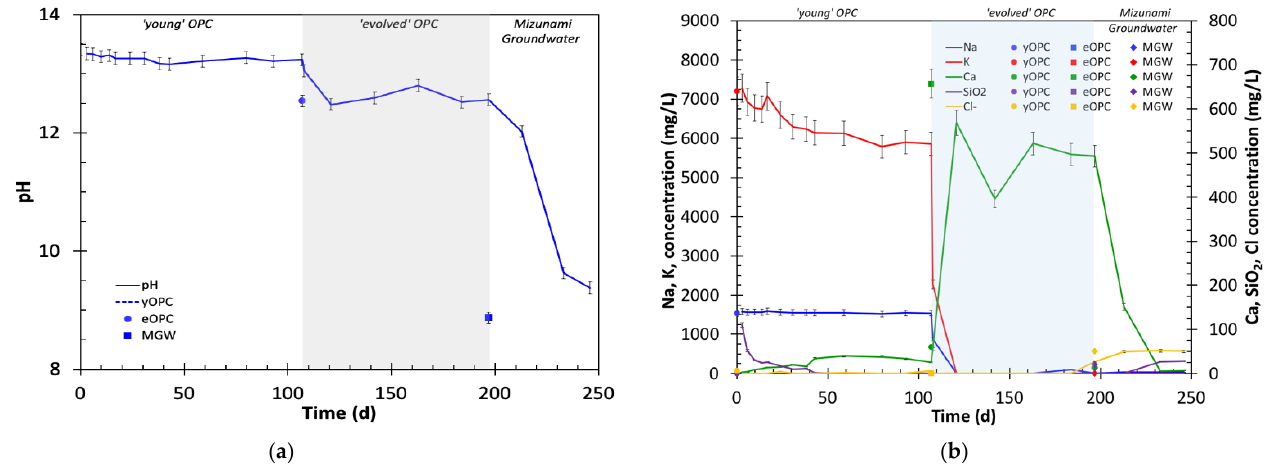
Figure 4. Major changes in fluid chemistry with time (Col-3). Tokai granite with ‘young’ OPC, and then the ‘evolved’ OPC leachate followed by MGW. ( a ) pH; ( b ) [Na], [K], [Ca], [SiO 2 ], and [Cl]. Legend text: yOPC-‘young’ OPC leachate, eOPC-‘evolved’ OPC leachate, MGW-Mizunami groundwater. Lines indicate concentrations in reacted samples; single points the original concentration in the reacting fluids.